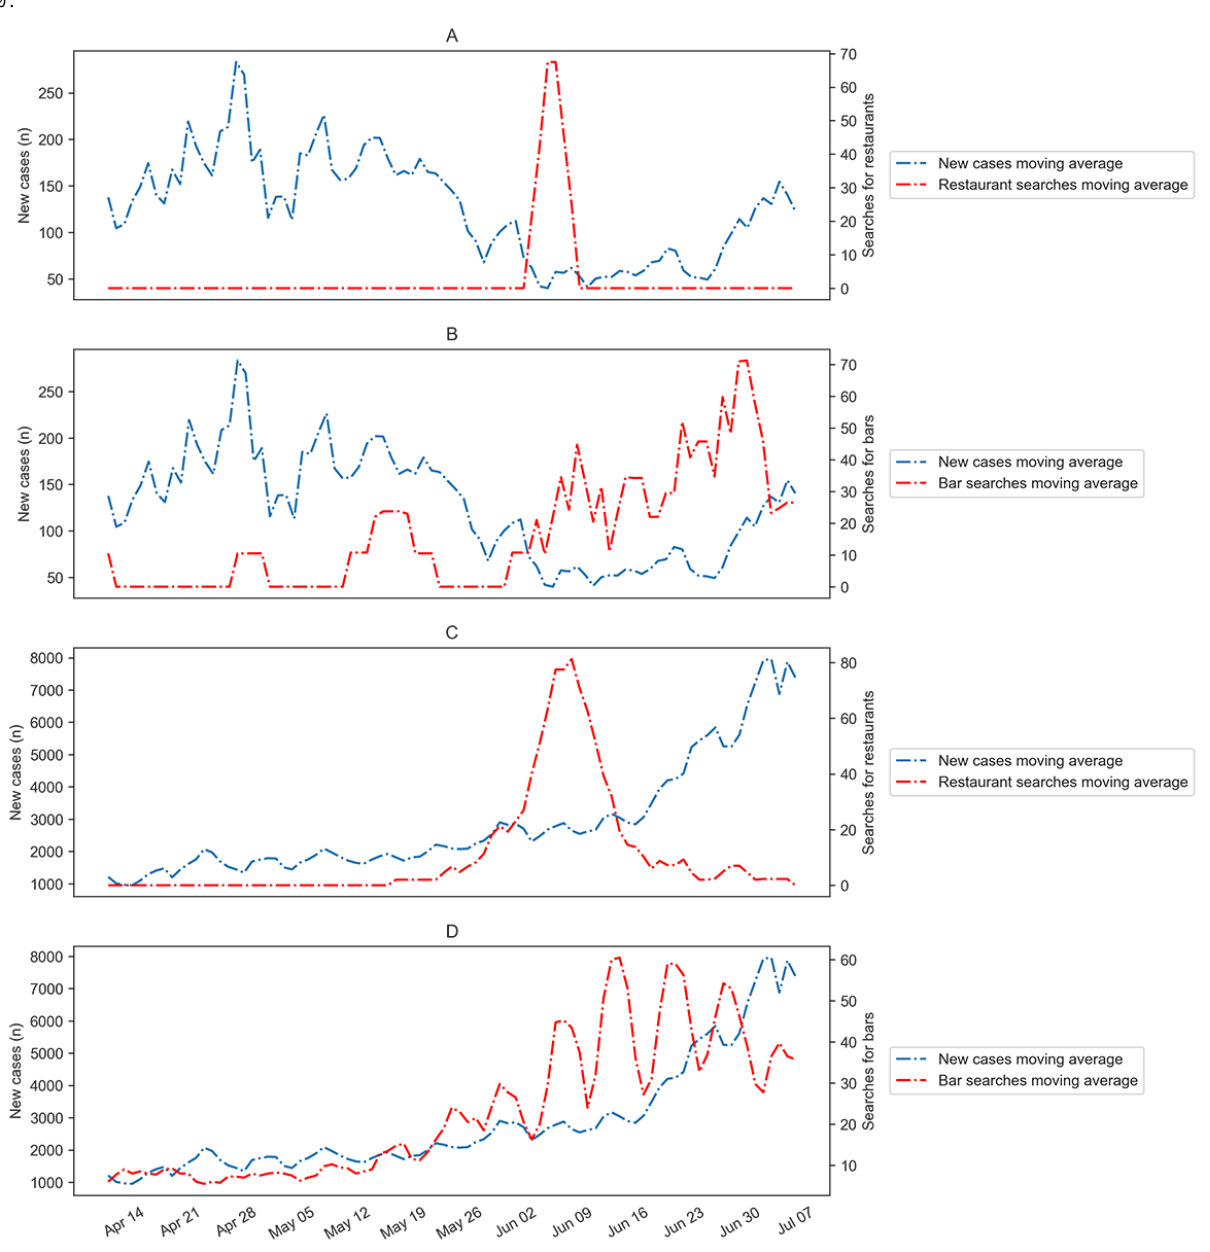
Figure 2. Effects of restaurant and bar search trends on daily cases of COVID-19 in Delaware (A, B) and California (C, D) from April 9 to July